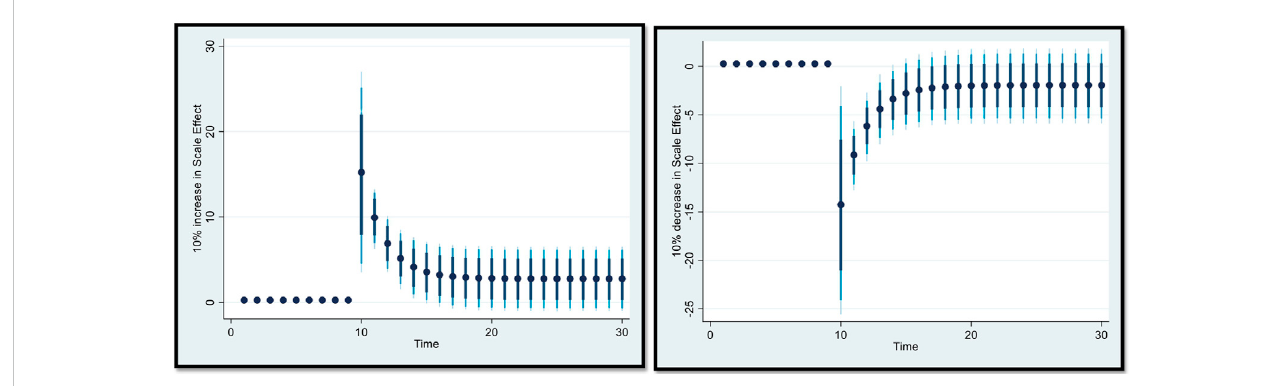
FIGURE 1 Impulse response plot for scale effect (economic growth) and CO 2 emissions. An increase and a decrease of 10% in scale effect and its effect on CO 2 emissions, where dots denote the average prediction value. The dark blue to light blue lines show 75%, 90%, and 95% con fi dence intervals, respectively.